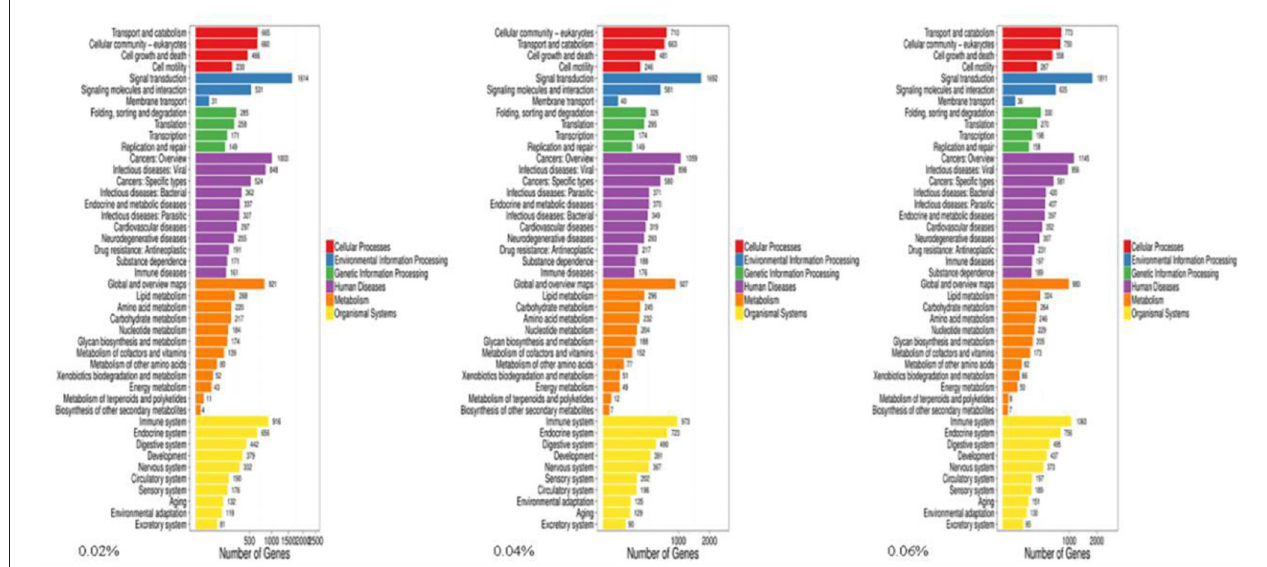
FIGURE 3 | KEGG of differentially expressed genes in control and quercetin (0.02, 0.04, and 0.06%).